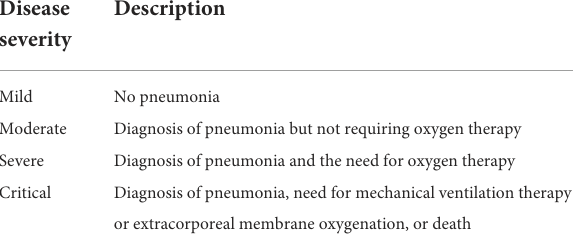
TABLE 1 Four groups of disease severity.